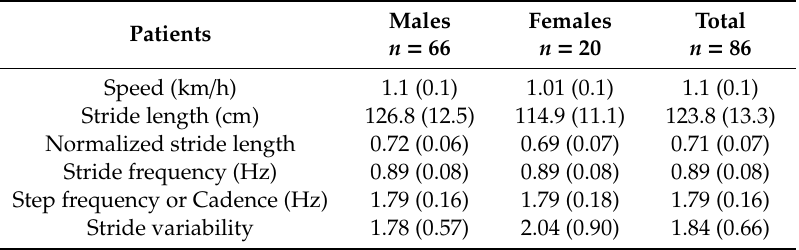
Table 1. Values of spatiotemporal gait parameters measured with the Optogait system. Mean (standard deviation).